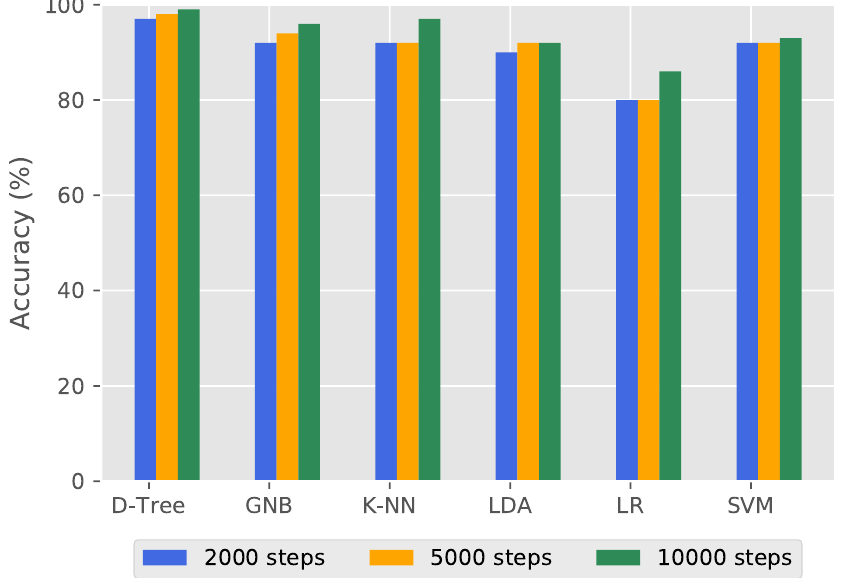
Figure 11. Average accuracy with a different number of